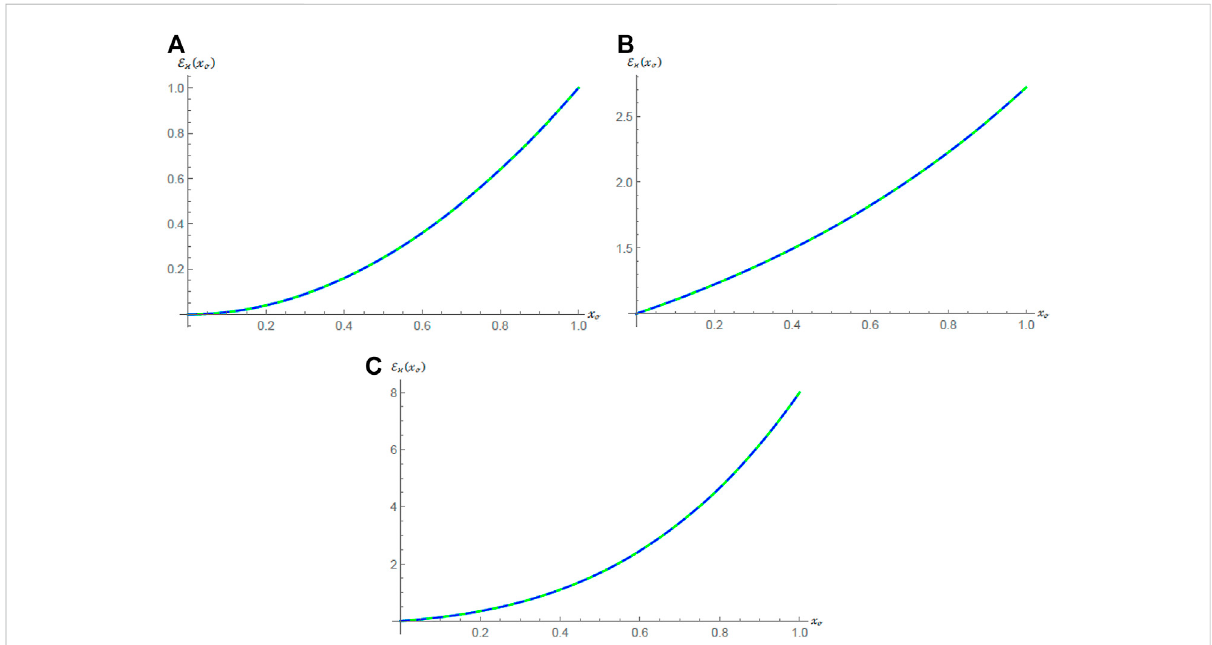
FIGURE 1 2- D Cartesian plots of the RKHA numeric solution of the FLM platform over Ξ : (A) application 1, when ( α , β ) (cid:2) ( 1/2 , 4/5 ) ; (B) application 2, when ( α , β ) (cid:2) ( 1/3 , 3/4 ) ; and (C) application 3, when ( α , β ) (cid:2) ( 1/4 , 4/5 )